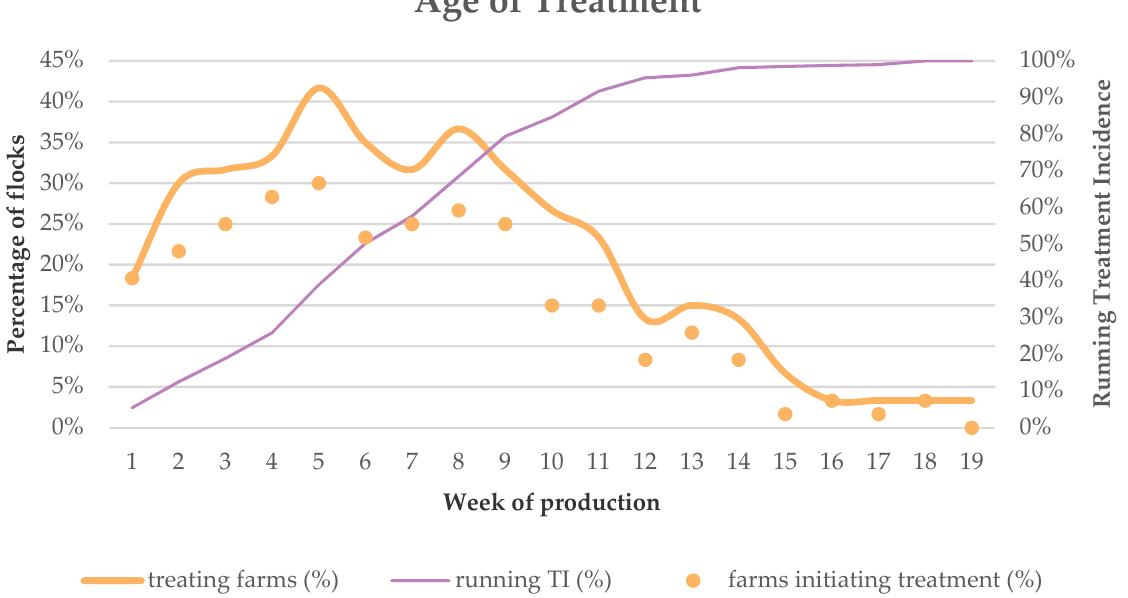
Figure 4. The age of treatment with antimicrobials of the 60 turkey flocks. The dots show the proportion (%) of turkey flocks (on the y -axis) where treatments with antimicrobials were initiated in a certain week of production ( x -axis). The orange full line shows the proportion (%) of turkey flocks (left y -axis) that were being treated with antimicrobials in a certain week of production ( x -axis). The purple full line shows the running treatment incidence (left y -axis) over the production cycle in weeks ( x -axis).